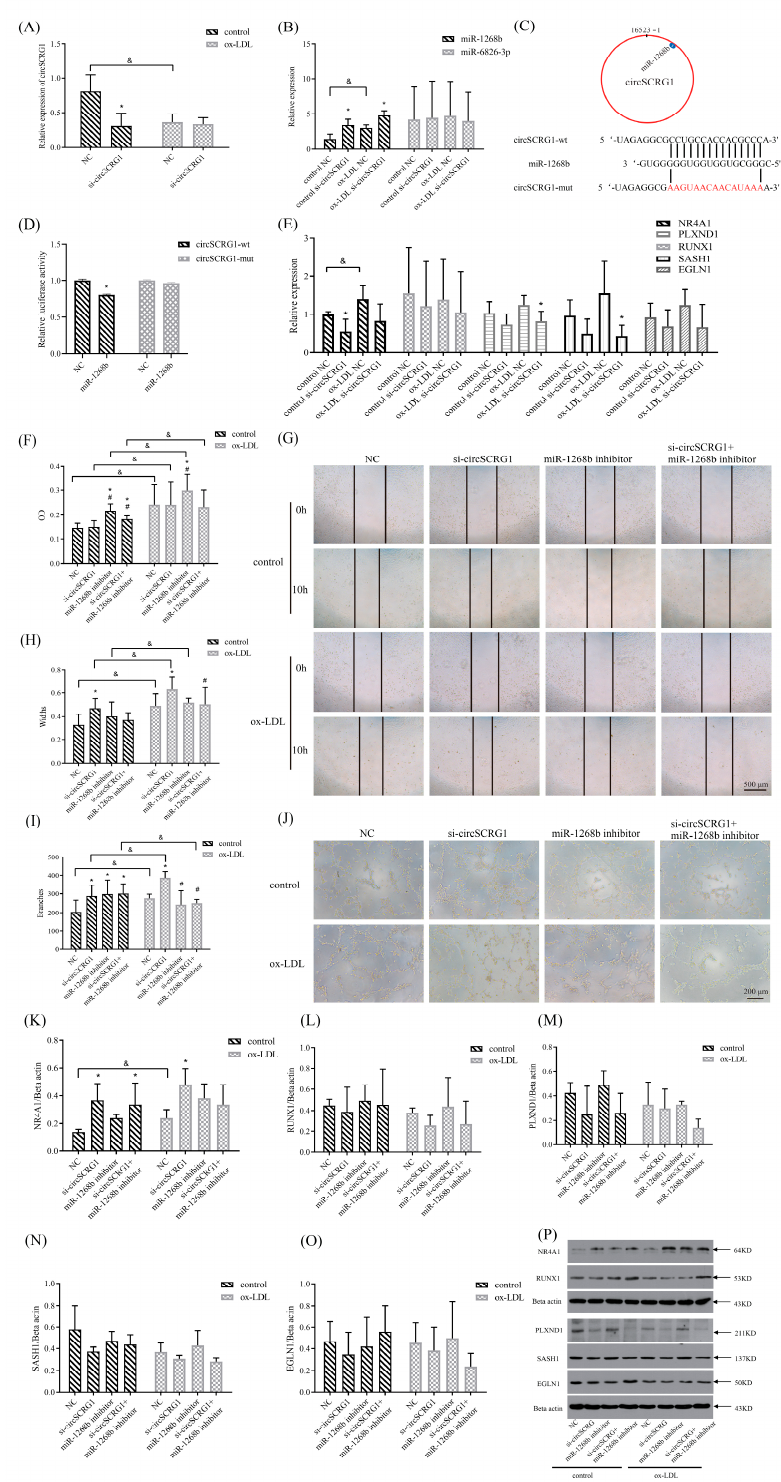
Figure 3. si-circSCRG1 promoted ox-LDL-induced angiogenesis by interacting with miR-1268b to up-regulate the target gene nuclear receptor subfamily 4 group A member 1 (NR4A1). ( A , B ) Control or ox-LDL-induced HUVECs were transfected with 100 nmol/L si-circSCRG1 or NC for 24 h. The relative expression levels of circSCRG1, miR-1268b and miR-6826-3p were evaluated by RT-qPCR. ( C ) Schematic of putative miR-1268b-binding sites on circSCRG1 and sequence